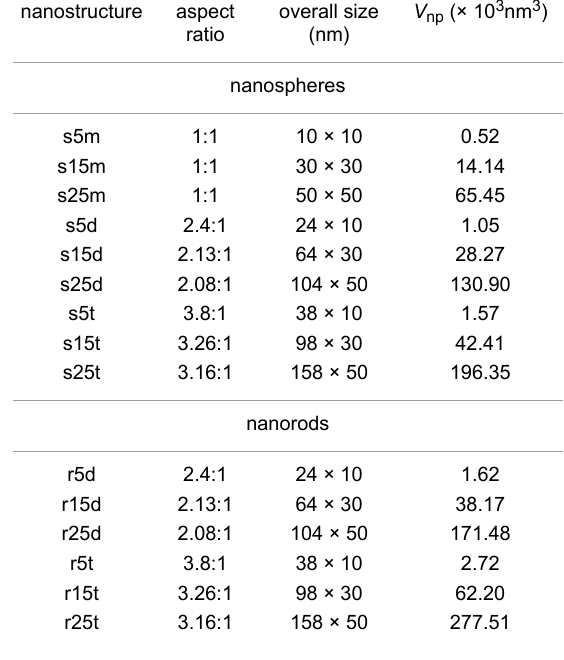
Table 1: Gold nanoparticle types and dimensions used in the model. The letters “s”, “r”, “m”, “d” and “t” stands for sphere, rod, monomer, dimer and trimer, respectively. The number defines the radius of the nanosphere or nanorod in nanometers. The gold nanorods were modeled having an overall size of the corresponding nanosphere assembly with matching aspect ratios. For nanosphere assemblies the inter-particle distance, edge to edge, was kept at a constant value of 4 nm. The nanoparticle volume, V np , for gold nanosphere assemblies is given as the sum of the individual nanoparticle